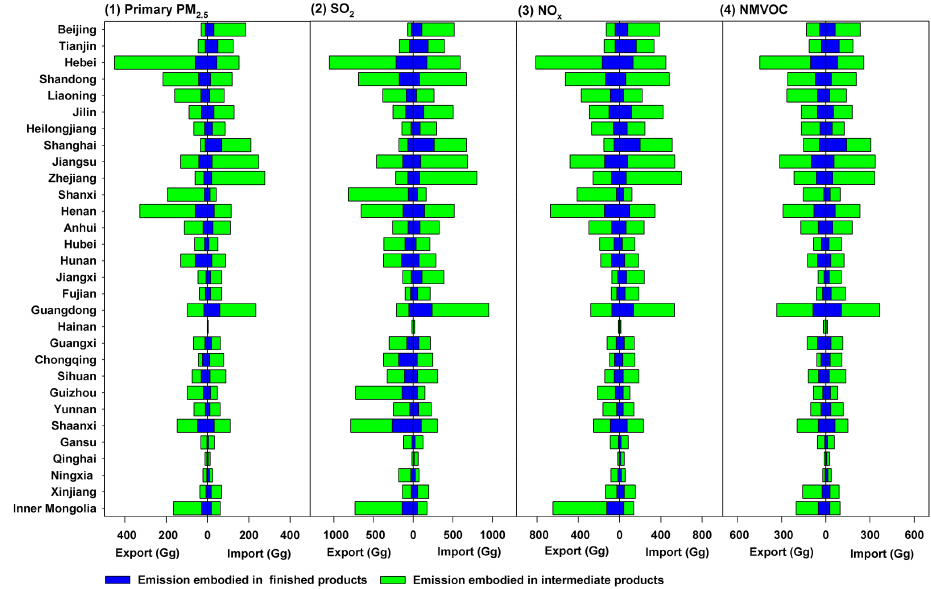
Figure 3. Balance of air pollutant emissions embodied in each province’s interprovincial